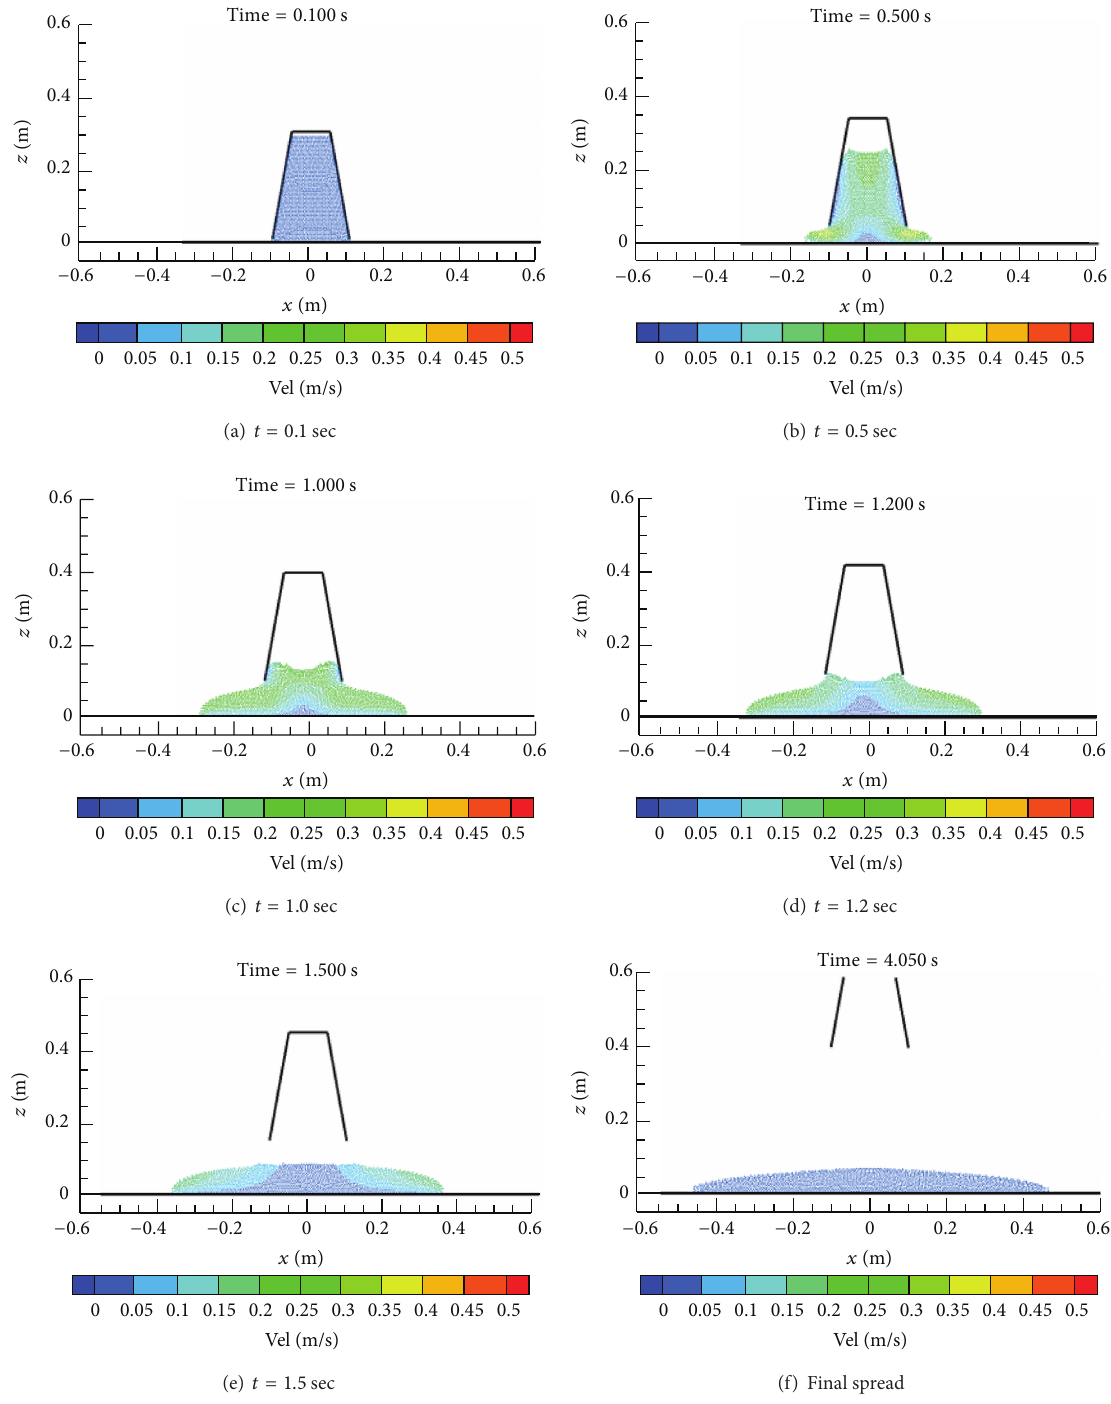
Figure 2: The velocity distribution during slump